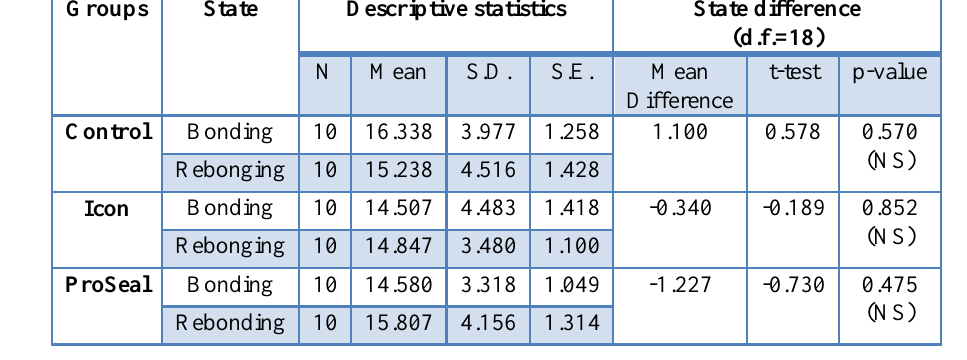
Table 3: Comparison of the shear bond strength between the correspondence subgroups of the bonding and rebonding group.